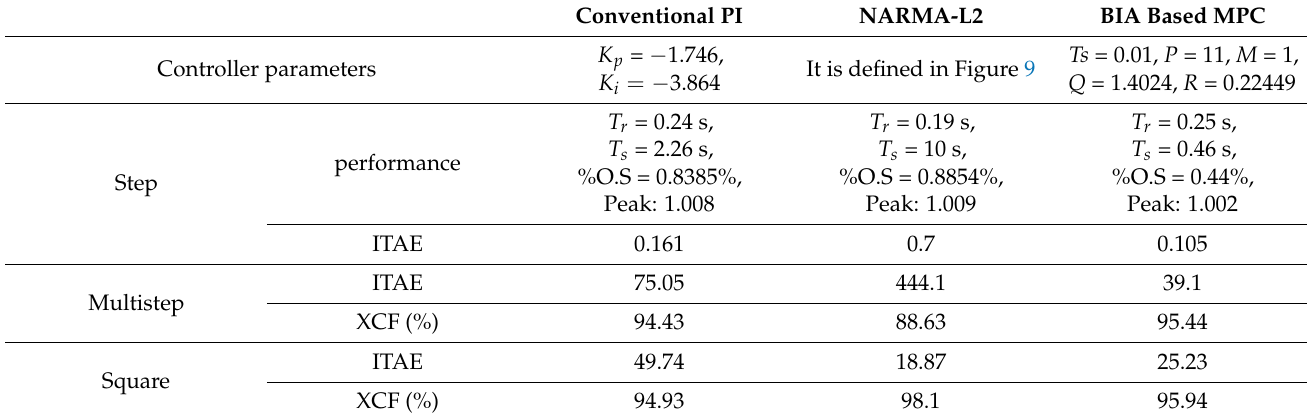
Table 1. The optimum value of controller parameters and performance criteria.